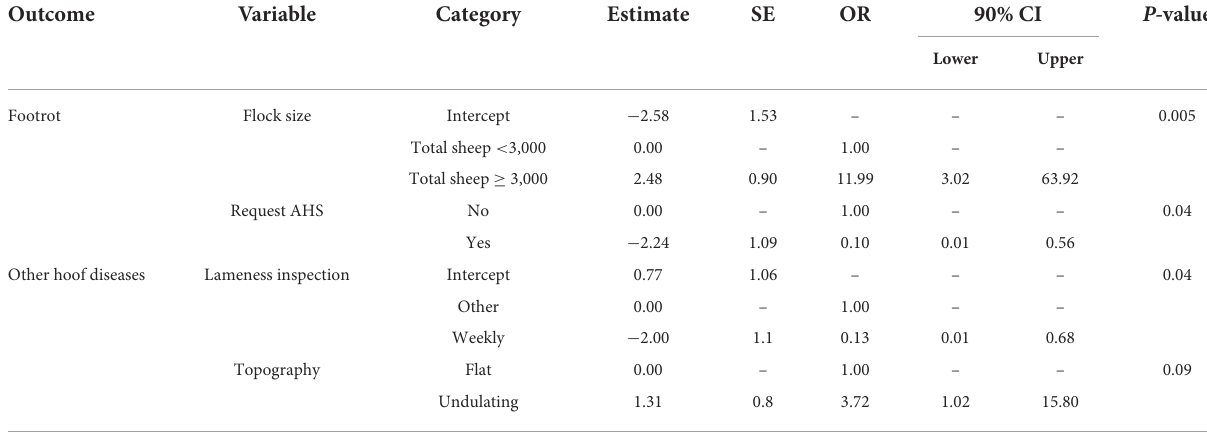
TABLE 6 Multivariable models for the binary outcome variables: Presence of any clinical form of footrot; presence of other hoof diseases ( P -value ≥ 0.1).